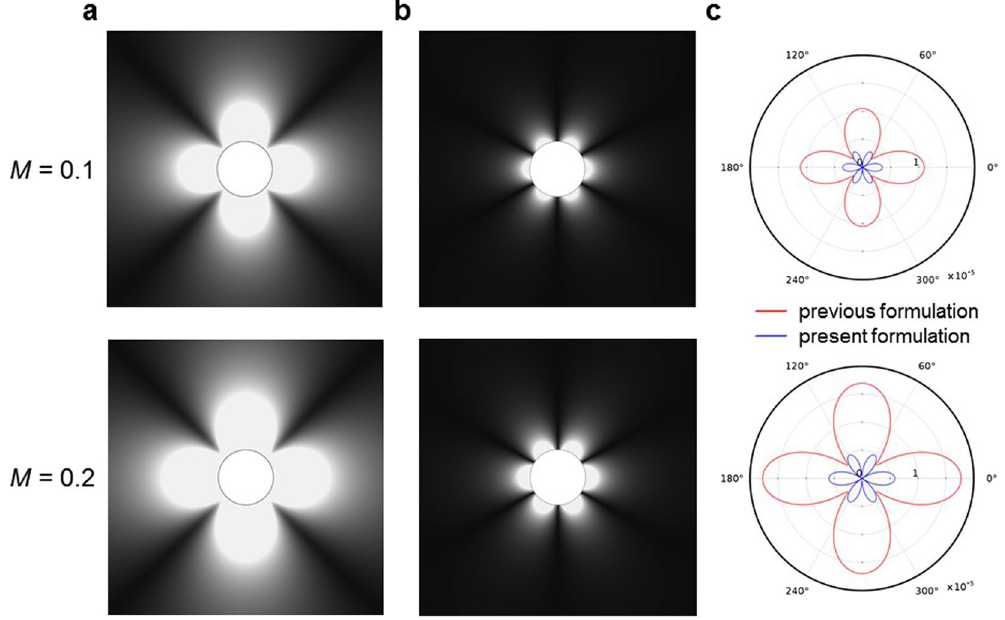
Figure 4. Comparison of the equivalent source terms between the previous and present formulations. ( a ) The magnitudes of equivalent source in the previous formulation 7 . ( b ) The magnitudes of equivalent source in the present formulation. ( c ) Comparison of directivity plots along the surface of the acoustic cloak ( r = R 2 ). In all figures, the Helmholtz numbers are set as kR 1 = 3. As shown in ( a ), the magnitude of the equivalent source in the previous formulation increases as the Mach number increases and the polarity shows the quadrupole patterns. As shown in ( b ), the magnitude of the equivalent source in the present formulation also increases as the Mach number increases, and the polarity shows the hexapole patterns. As shown in ( c ), the different polarities and magnitudes of the equivalent sources are more clearly seen. The magnitude of the previous formulation is much larger than the one of the present formulation. It is because the previous formulation introduced the velocity difference term v = u 0 − u ∞ in the equivalent source term in order to make the uniform wave operator. On the other hand, the present formulation has non-uniform wave operator, and all the equivalent sources are due to the fluid compressibility and flow non-uniformity by